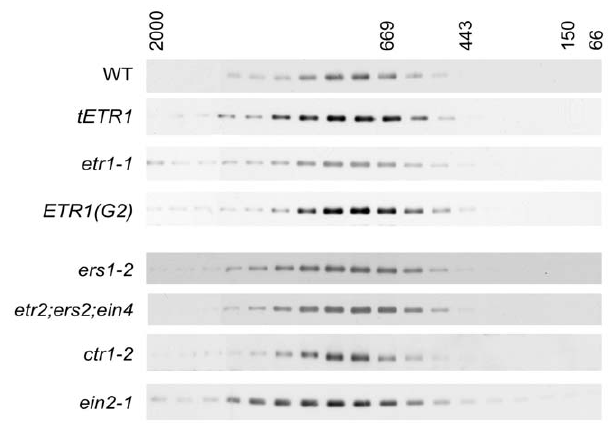
Figure 7. Effect of ethylene pathway mutations on the size of the ETR1 protein complex. LPC-solubilized microsomes were fractionated on Superose 6HR and the elution profile for ETR1 determined by immunoblot analysis. Analysis was performed in a line where additional copies of ETR1 was trangenically expressed (tETR1), in a line containing an ethylene-insensitive mutation in ETR1 ( etr1-1 ), and in a line containing a kinase-deficient version of ETR1 (ETR1-G2). Analysis was also performed in lines containing mutations in other members of the ethylene receptor family (the single mutant ers1-2 and the triple mutant etr2/ers2/ein4 ), and in the downstream pathway components CTR1 and EIN2 .